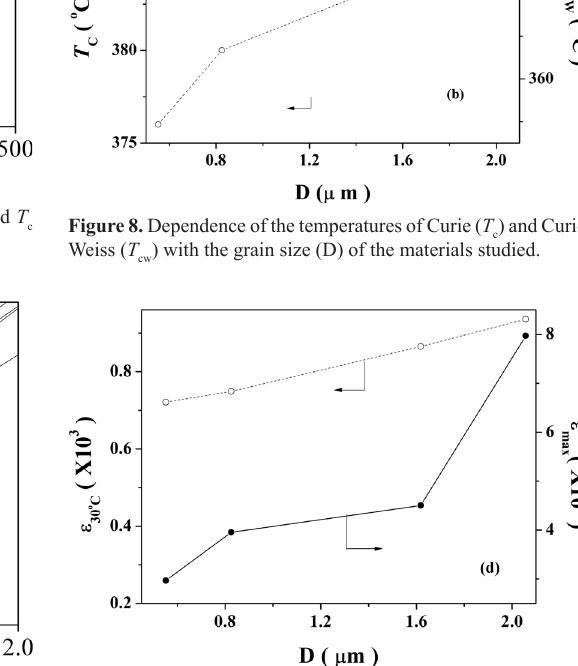
) and permittivity m ) with the grain size (D) of the C